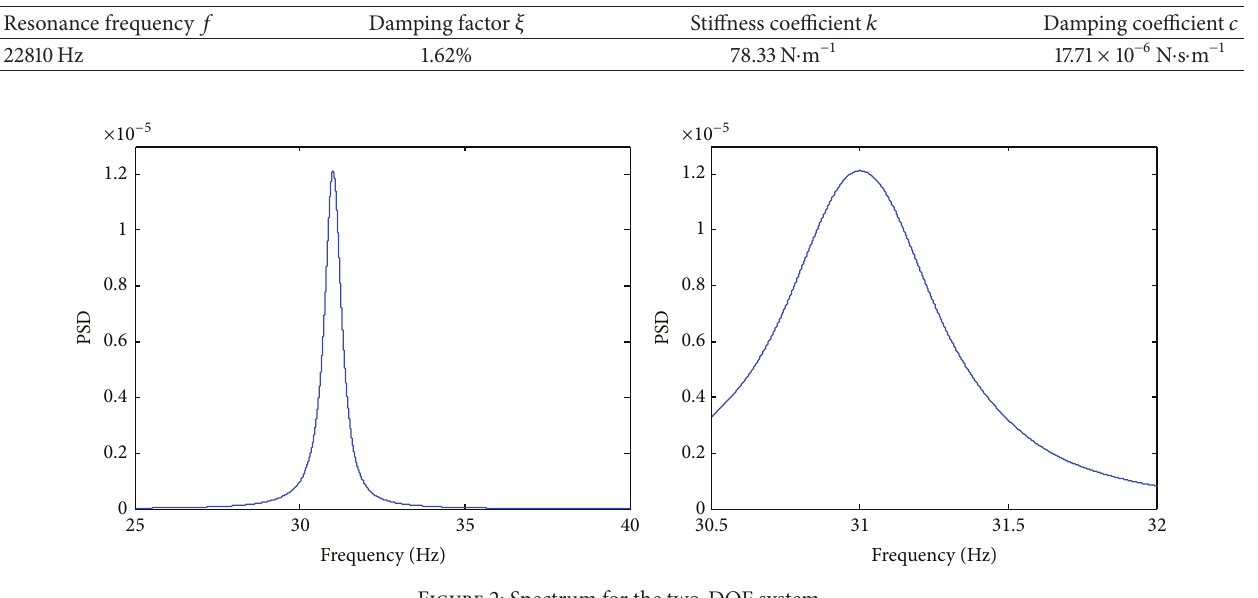
Table 3: Parameters identification of the perforated microplate.